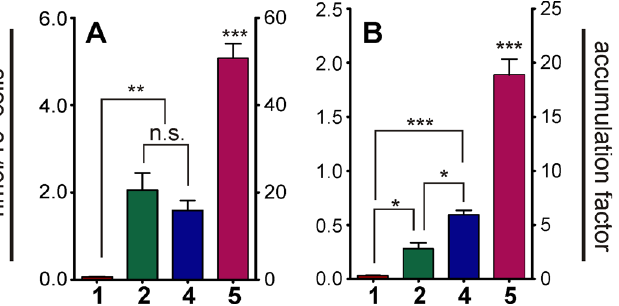
Fig 5. Accumulation of 1 and derivatives by HT-29 and NCI-H460 cells. Amount (mean ± SEM, N = 3 – 4) of cell-associated 1 , 2 , 4 and 5 , expressed as nmol/10 6 cells (left y-axis) and cellular enrichment (right y-axis) in HT-29 (A) and NCI-H460 (B) cells. A mean cell volume of 3 pL was used to calculate accumulation factors. Significance was calculated using one-way Anova: n.s.: not significant; * : p < 0.05; ** : p < 0.01, *** : p <